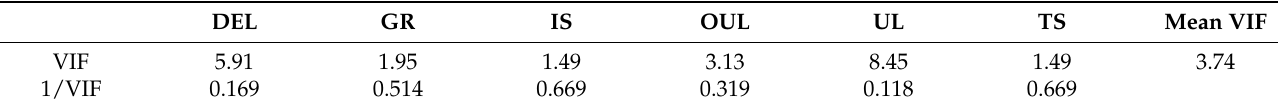
Table 6. The VIF test.